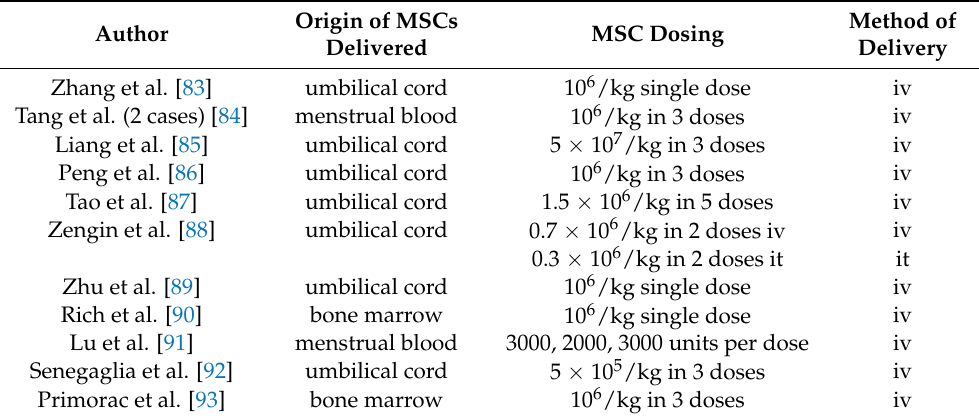
Table 1. Case reports of MSC treatment of COVID-19.